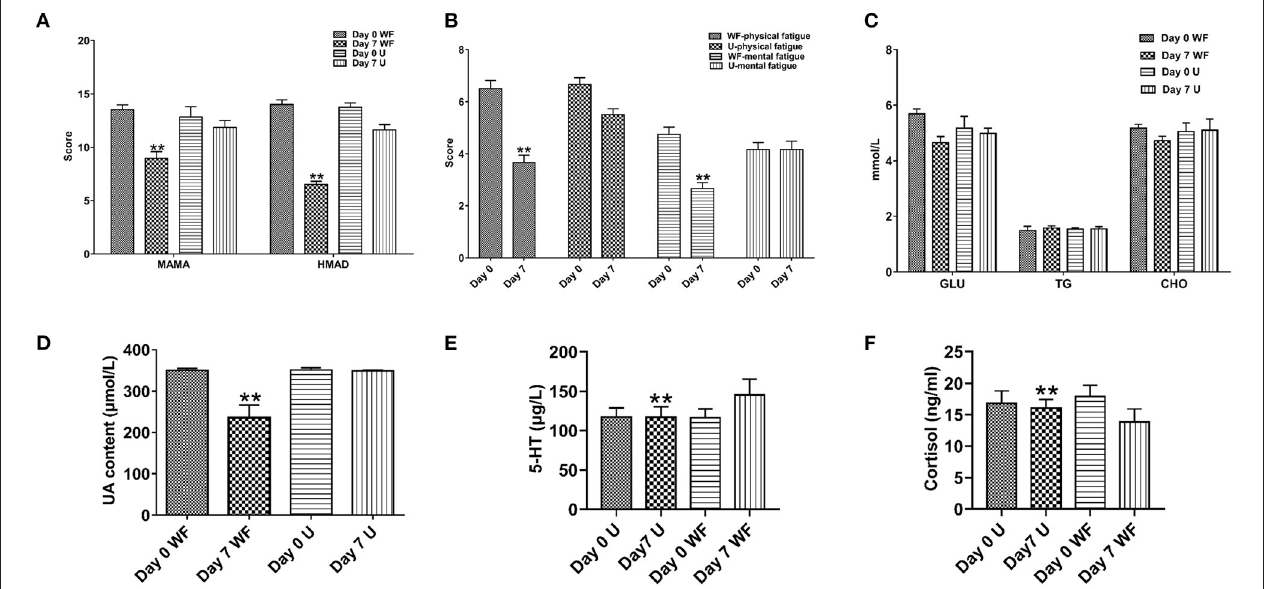
FIGURE 1 | Effects of the waterfall forest environment (WF) on psychological symptoms and physiological indexes. (A) Hamilton Anxiety Scale (HAMA) and Hamilton Depression Scale (HAMD). (B) Fatigue Scale-14 (FS-14). (C) Effects of the WF on the content of serum glucose (GLU), triglycerides (TG), and total cholesterol (CHO).